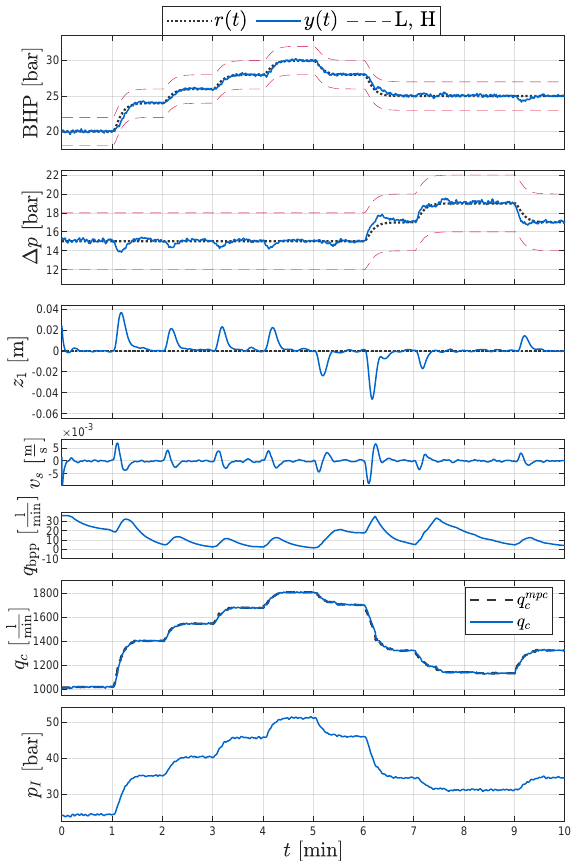
Figure 10: System response to tracking multiple set- points.